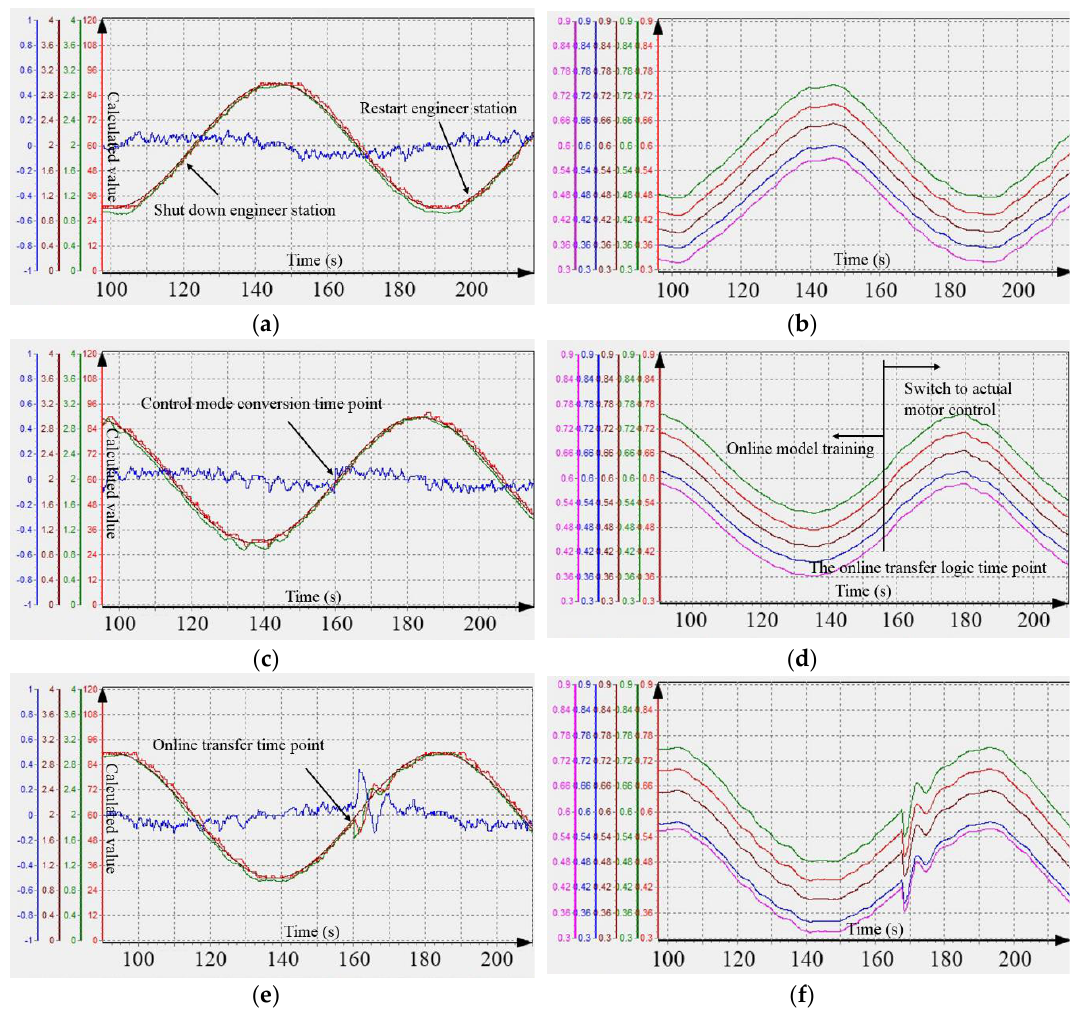
Figure 17. Dynamic characteristics analysis curves under control mode switching between advanced control and normal control. ( a ) Control curve under online delivery without disturbance; ( b ) Weight update curve under online delivery without disturbance; ( c ) Change control method (PID converted to DRNN); ( d ) Weight update curve under change control method; ( e ) Dynamic additive di ff erence equation to modify motor internal characteristics; ( f ) Weight update curve under dynamic additive di ff erence